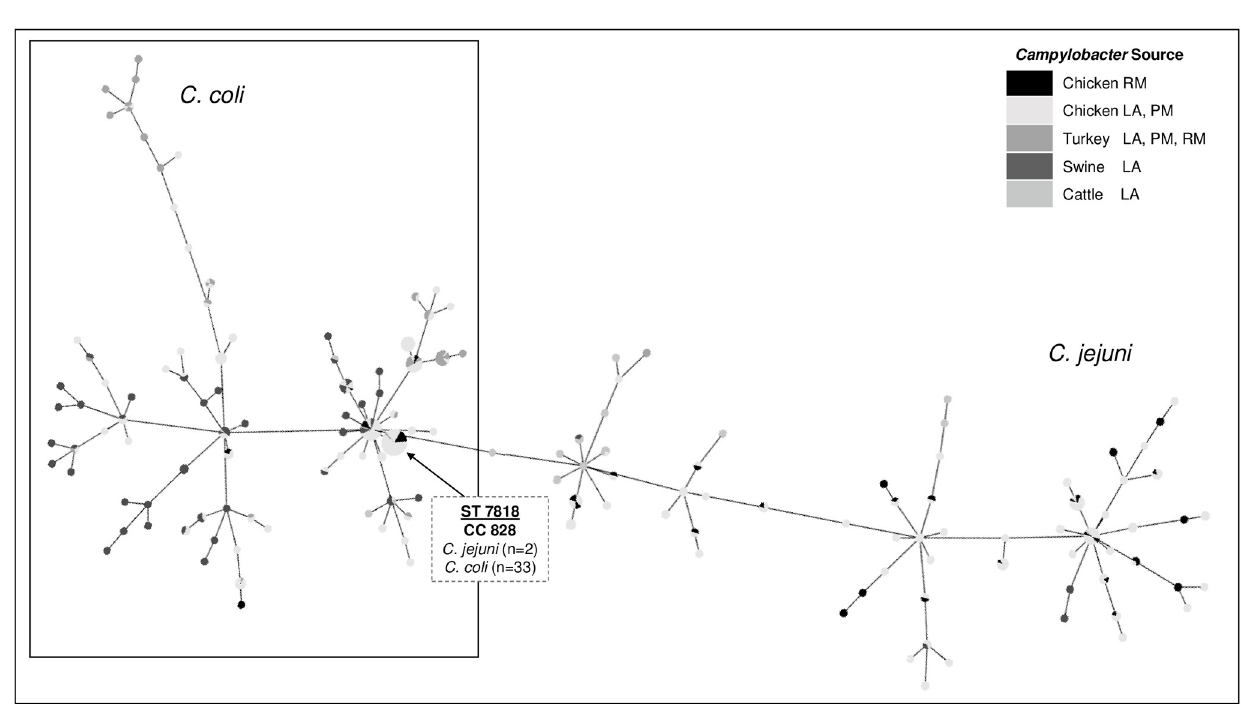
Fig 6. C . coli and C . jejuni MLST minimum spanning tree. Expansion generated by PHYLOVIZ software using an eBLAST algorithm. Link distances correlate to locus variations and represent the most likely relationship between isolates. Data points are colored by source according to the key. Isolates with unknown alleles were not included in the